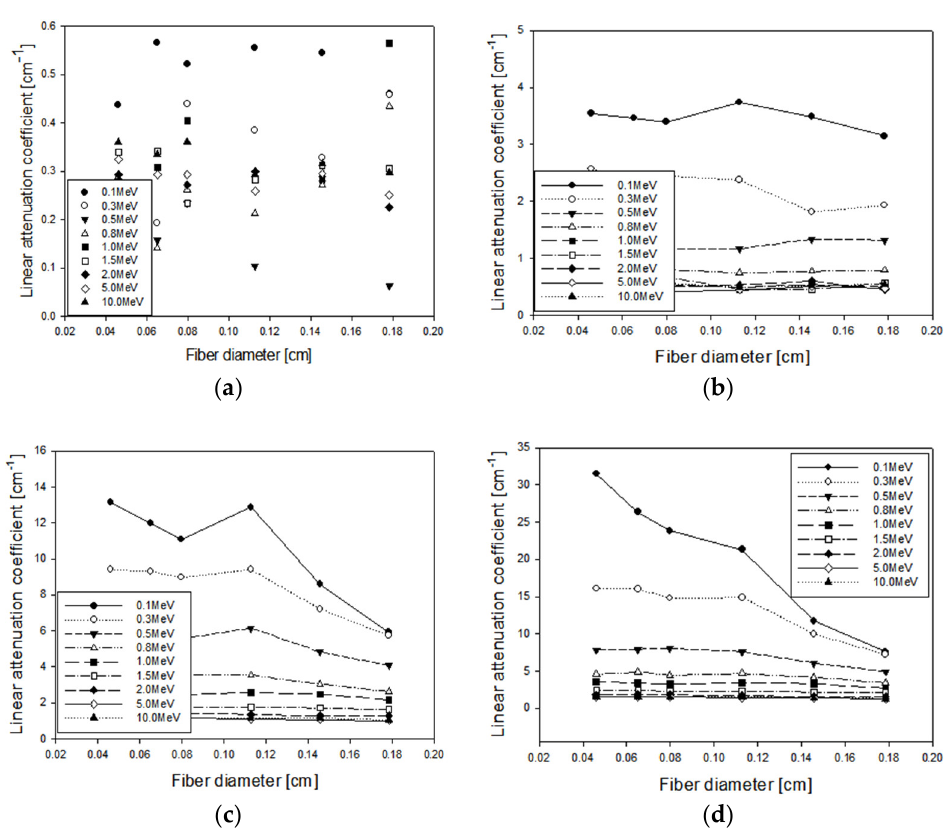
Figure 7. Linear attenuation coefficient of fibrous composite; ( a ) PE/concrete, ( b ) PE/copper, ( c ) PE/lead, ( d ) PE/tungsten.